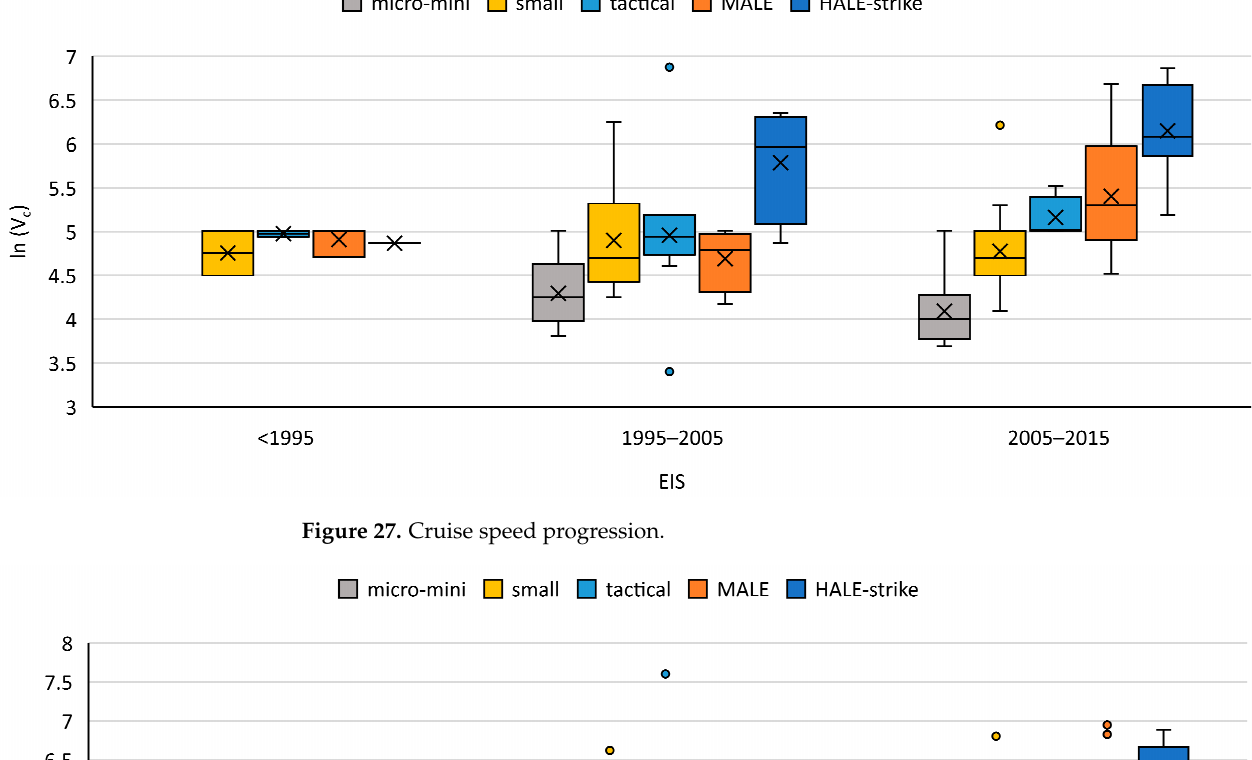
Figure 27. Cruise speed progression.